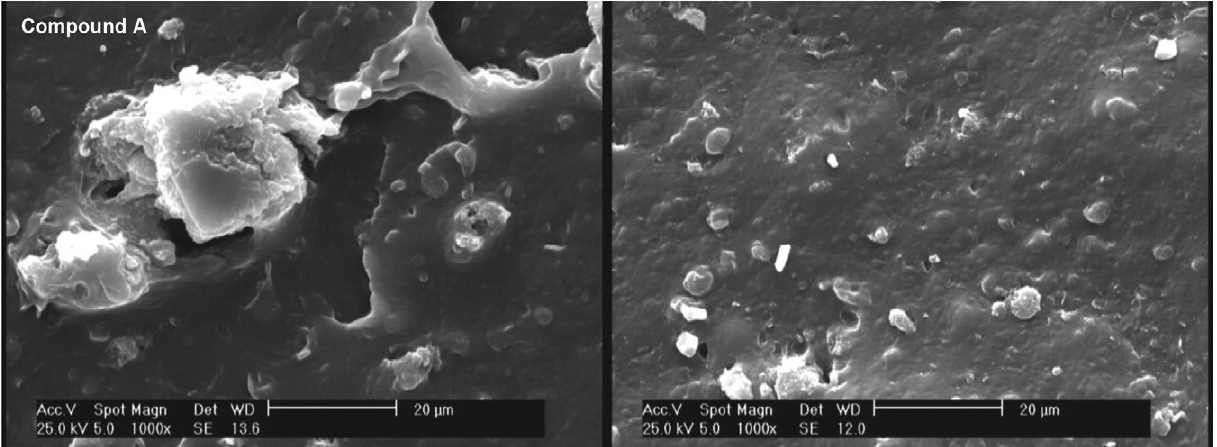
Figure 6. SEM images of compounds A and G.